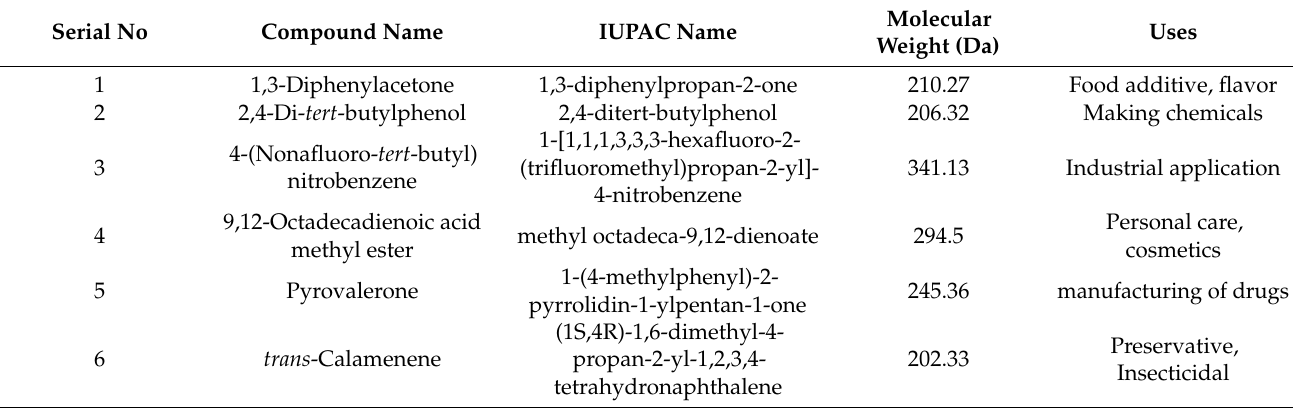
Table 13. Name, molecular weight, and uses of the selected CGJ specific volatile